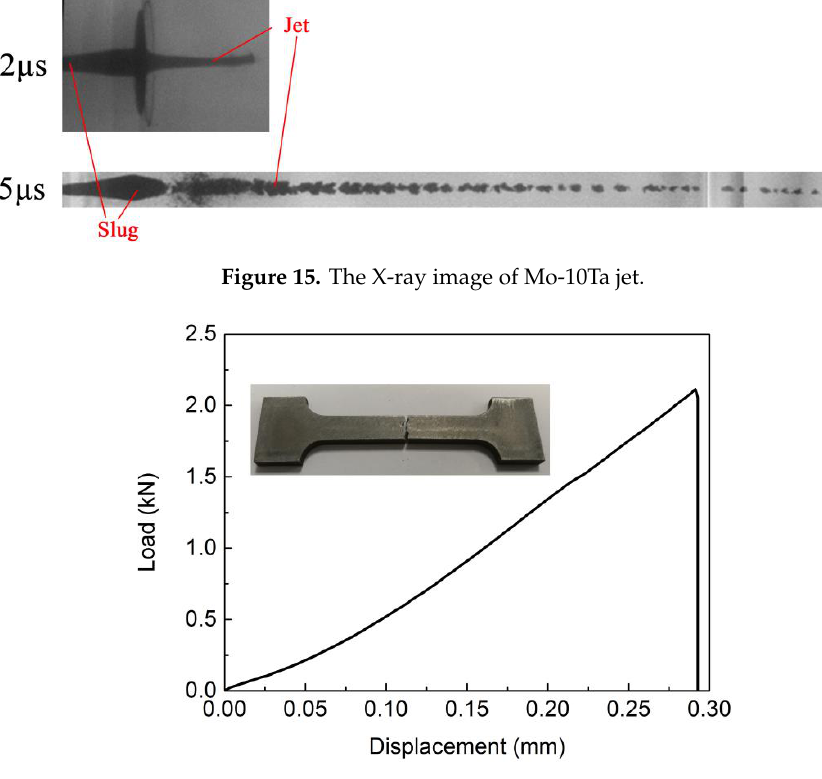
Figure 16. The displacement–load curve of Mo-10Ta under static tensile ( 286 K, 0.001 s −1 ).